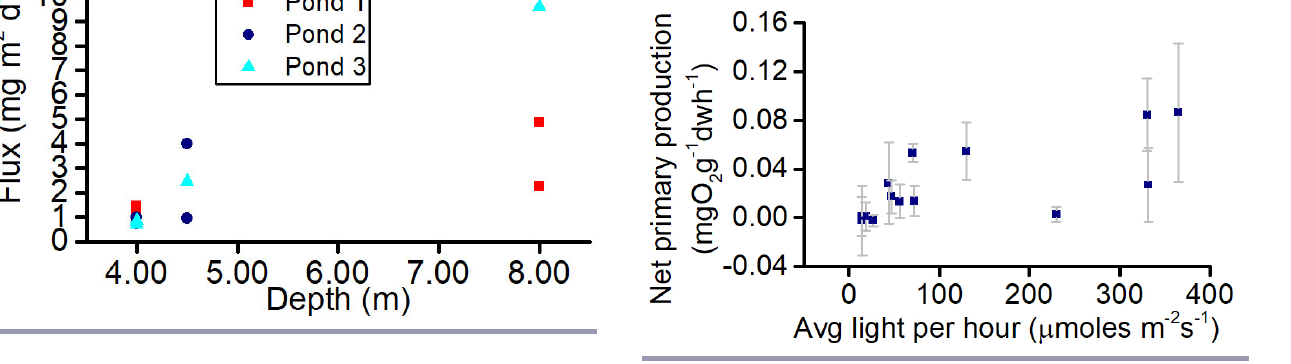
Fig. 4 . Hourly net primary productivity for macrophytes at different light exposures determined through the submersed domes